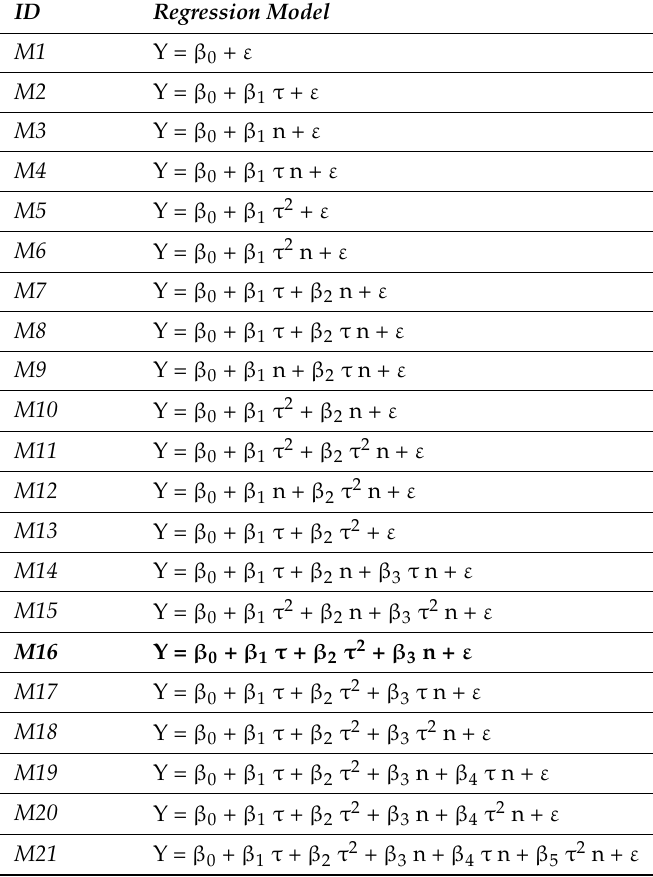
Table 2. The regression models used to fit transformed performances and the winning model parameters are listed. The models are sorted based on number of parameters. The models M1, M2, M3, M4, M7, M8, M9, and M14 are the standard linear regression models whereas the remainder of models has quadratic main factors and/or interactions. τ represents SOA (Stimulus Onset Asynchrony) and n represents CTOA (cue-target onset asynchronies). β ’s are the coefficients of the models and ε represents the error